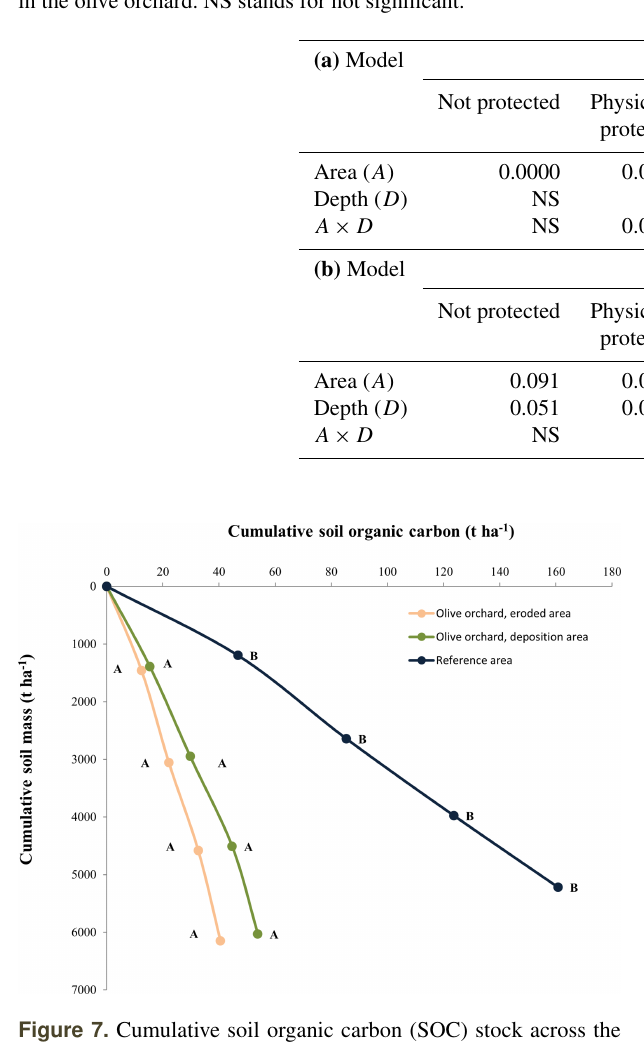
Table 3. Results of the two-way ANOVA of the distribution of the total soil organic carbon content in the soil among the different fractions of soil organic carbon, C org . In (a) area refers to the reference site vs. the olive orchard, and in (b) area refers to eroded vs. deposition areas in the olive orchard. NS stands for not significant.